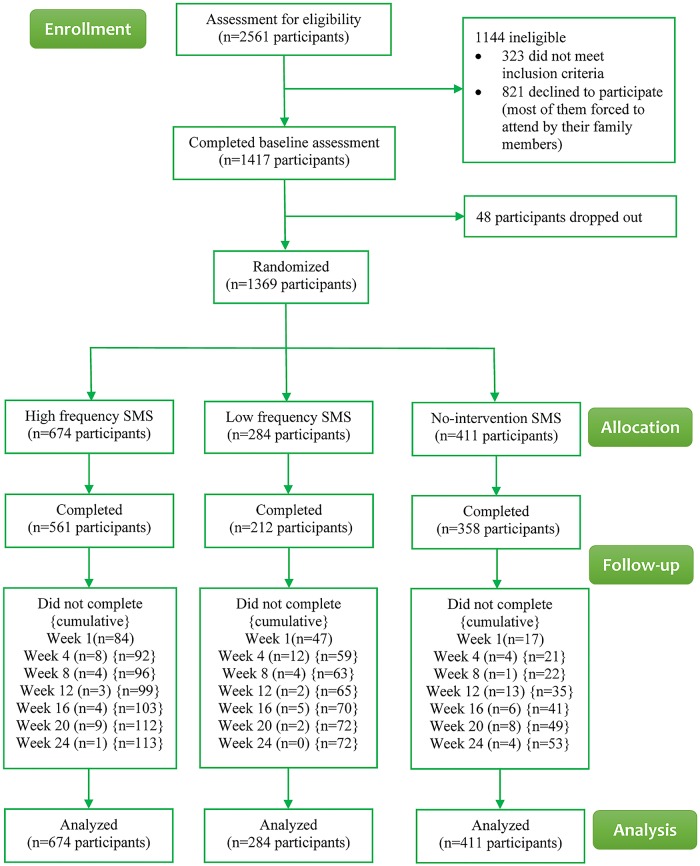
Flowchart of participants.SMS, short message service.